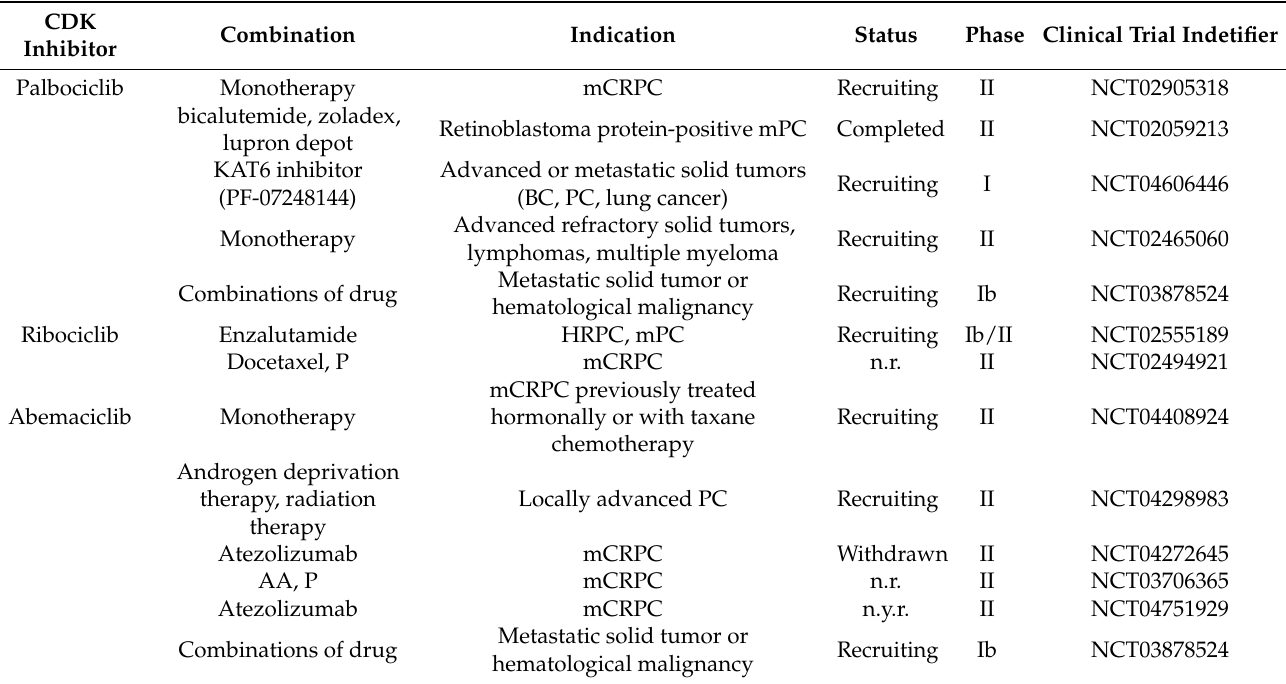
Table 3. List of clinical trials on cyclin-dependent kinase (CDK) inhibitors in connection with prostate cancer treatment, posted in last ten years (2011–2021), data are from ref.